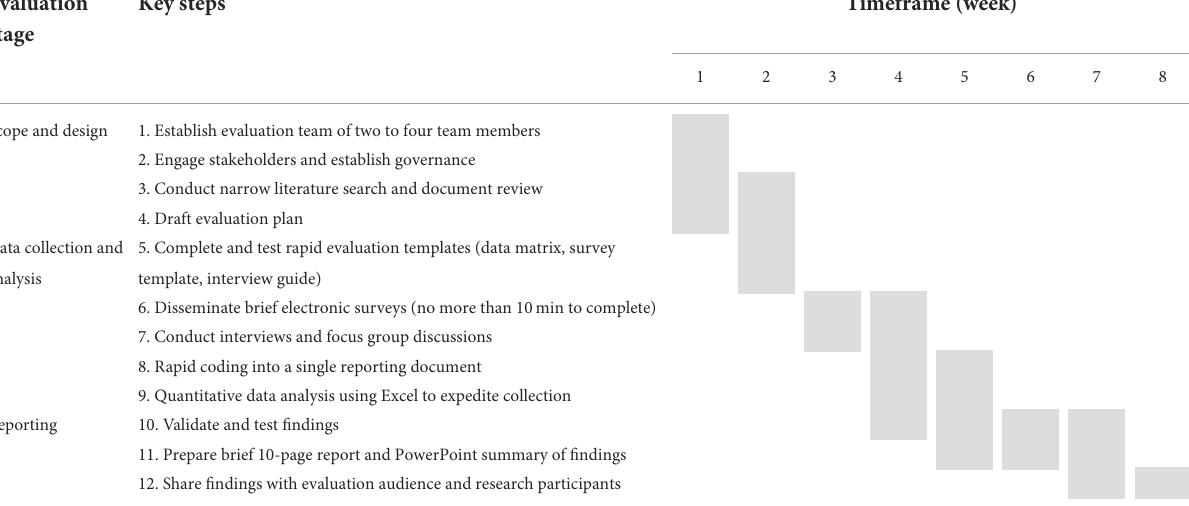
TABLE 2 Summary of key evaluation steps for implementing the 8-week tailored REM a